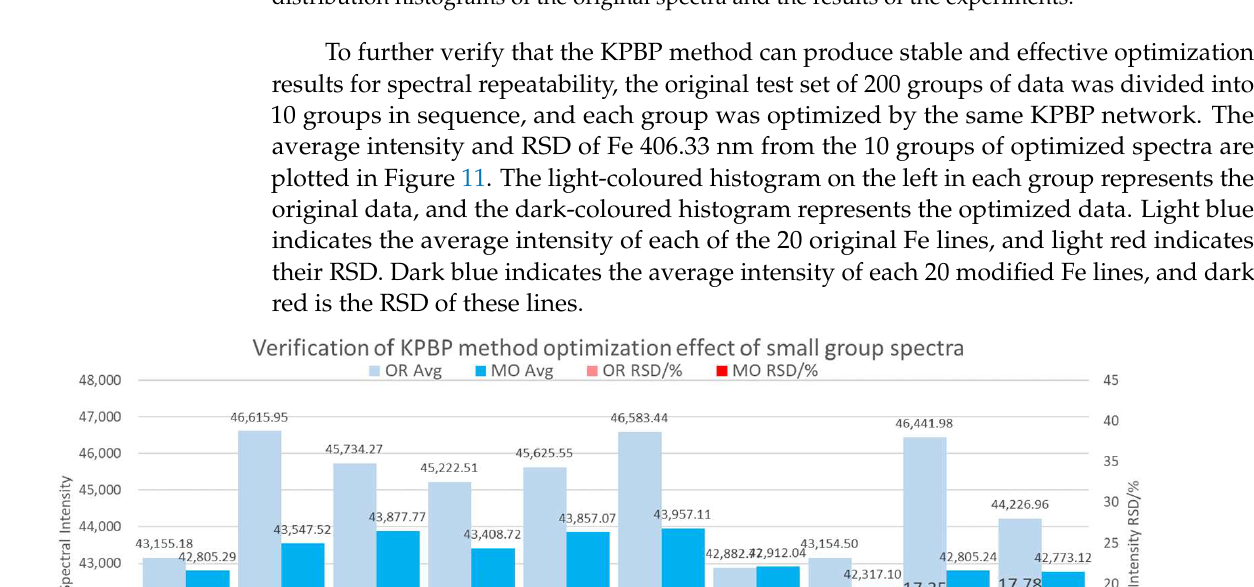
Figure 10. The effects of key parameters on KPBP results. ( a ) The average intensity and RSD of Fe 406.33 nm from the original spectra and the results of the experiments. ( b ) Fe 406.33 nm intensity distribution histograms of the original spectra and the results of the experiments.